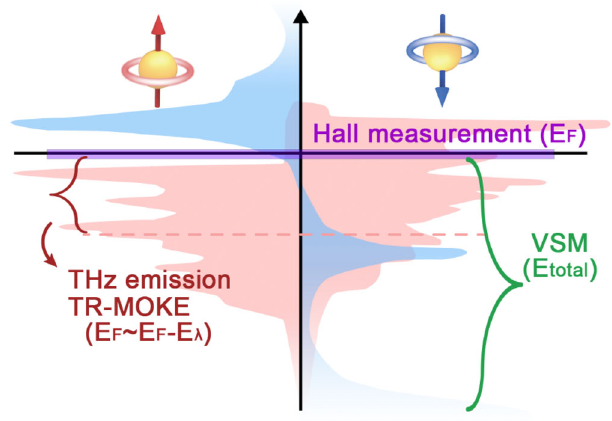
Fig. 1 | Schematic of spin-dependent band diagram of TbCo with accessible energylevelsbydifferentmeasurementtechniques. Redandbluecolorsdenote the band diagram of the Co 3 d -shell and the Tb 4 f -shell, respectively, which was reproduced from ref. 18 (10.1103/PhysRevB.88.104415). The covered energy levels for different measurement techniques are shown in the band